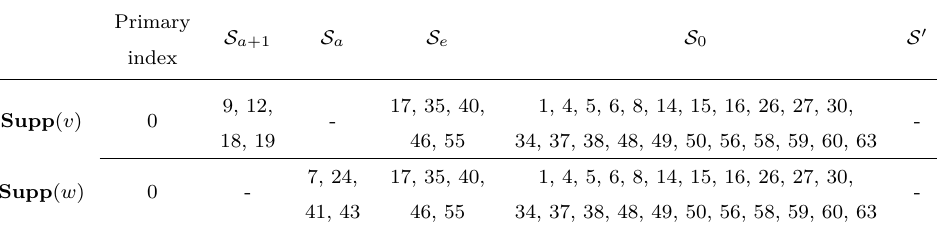
Table 4: Supports of v and w